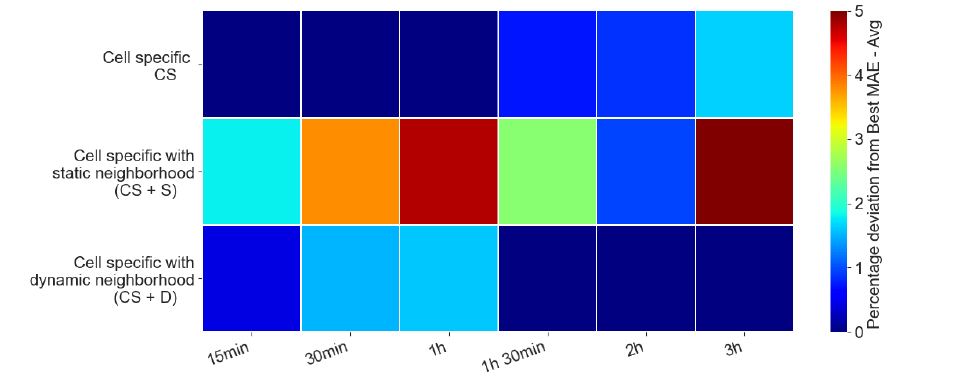
Figure 7. Combined effect of data model and prediction horizon.